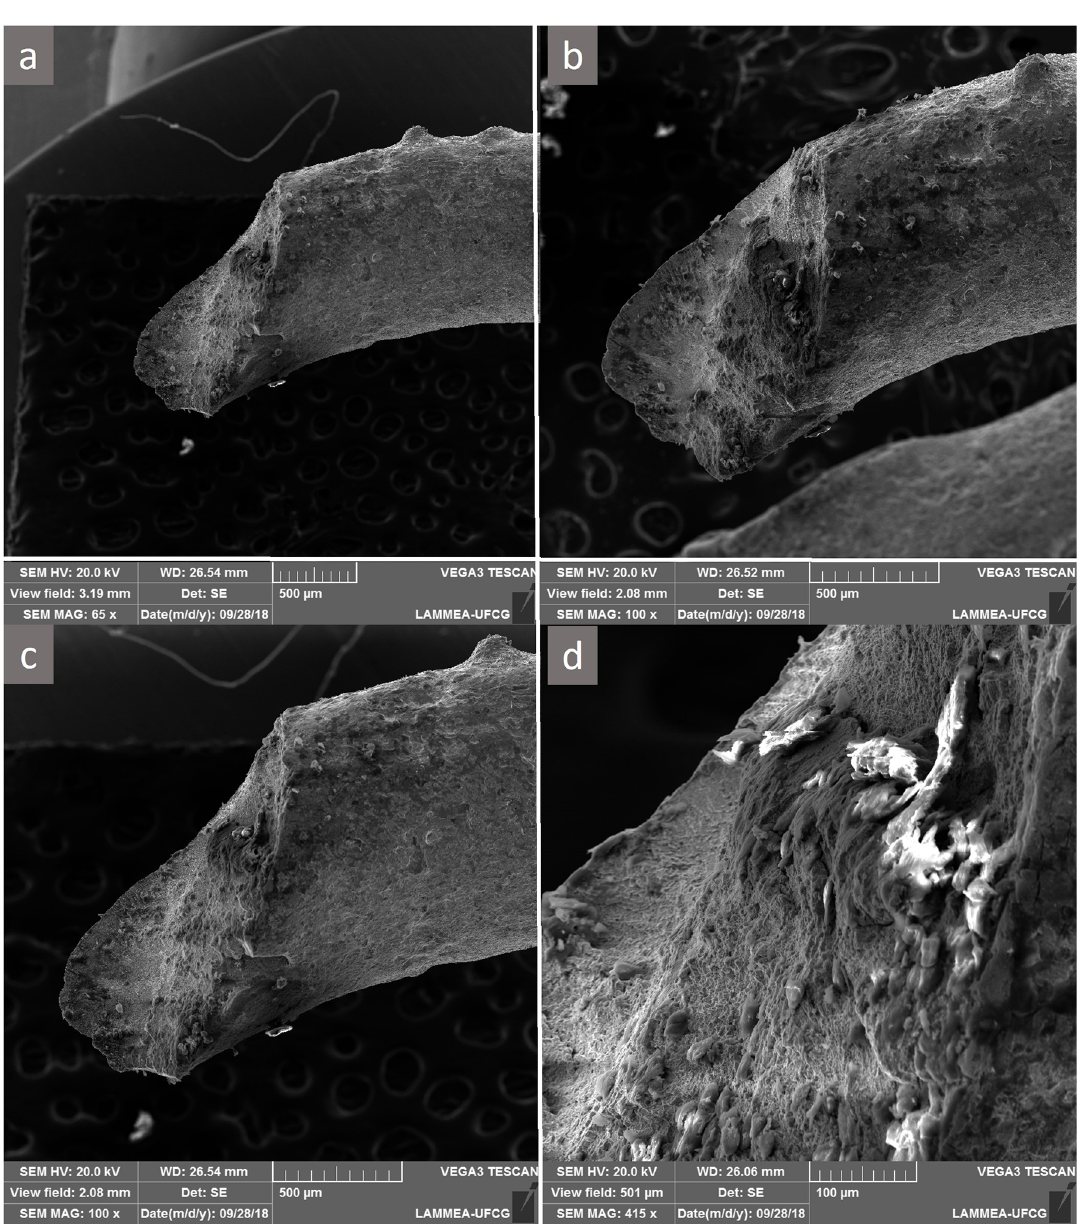
Figure 5. SEM of the SPG-D1.0 spring fractured surface after tensile tests. a) 65x. b) 100x. c) 100x. d)